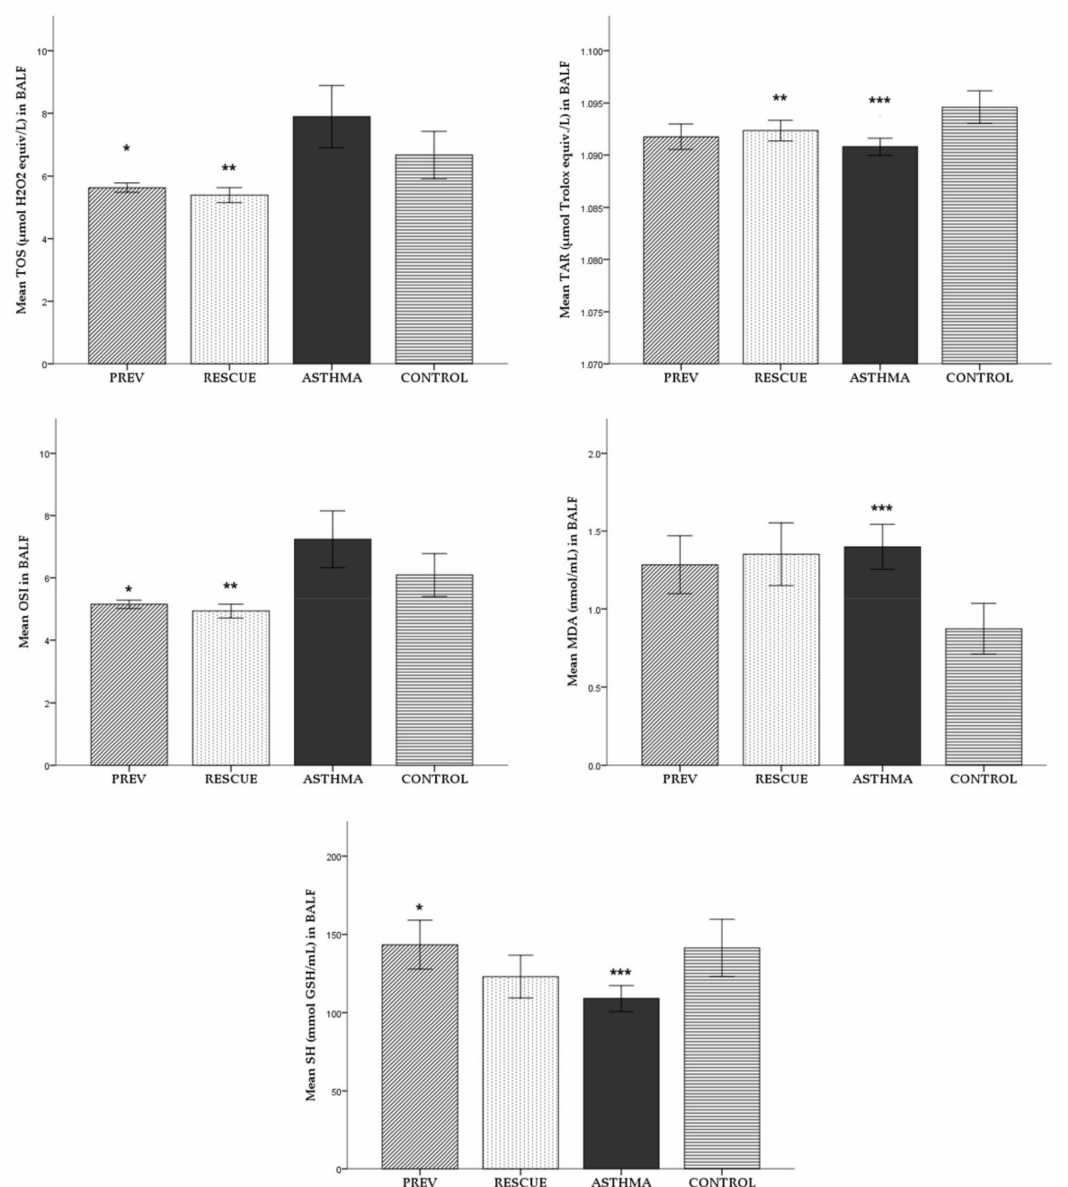
Figure 2. Mean levels ( ± standard deviation) of oxidative stress parameters in BALF. Comparison between experimental groups: * p < 0.05 PREV versus ASTHMA group; ** p < 0.05 RESCUE versus ASTHMA group; *** p < 0.05 ASTHMA versus CONTROL. Abbreviations: BALF = broncho-alveolar lavage fluid, TOS = total oxidative status, TAR = total antioxidant response, OSI = oxidative stress index, MDA = malondialdehyde, SH = total thiols; PREV = long-term low-dose vitamin D supplementation, RESCUE = short-term high-dose vitamin D supplementation, ASTHMA = positive control, CONTROL = negative